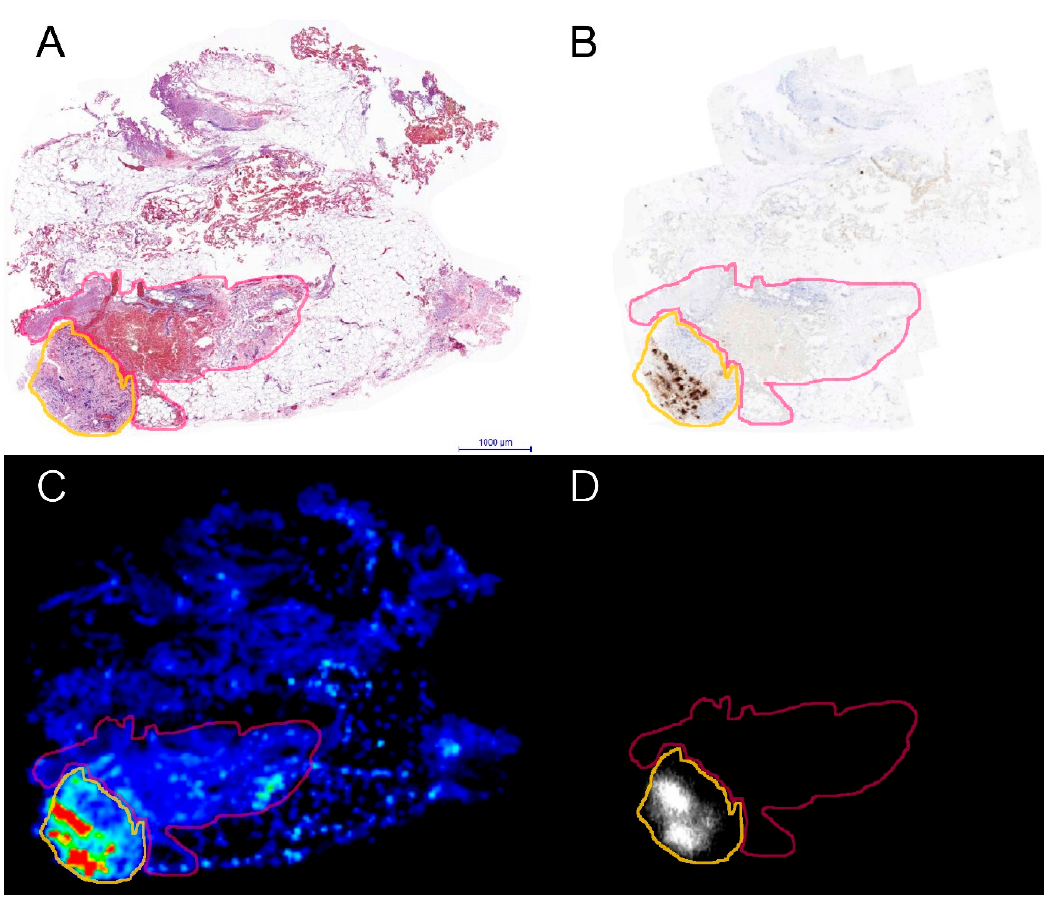
Figure 2. Example of an ROI for tumor (orange line) and surrounding tissue (pink line) as drawn on the H&E stained slide ( A ). ( B ) Consecutive slide with immunohistochemical CEA staining. ( C ) fluorescence flatbed image of the same slide as ( A ). ( D ) autoradiography image of the same slide as ( A ).